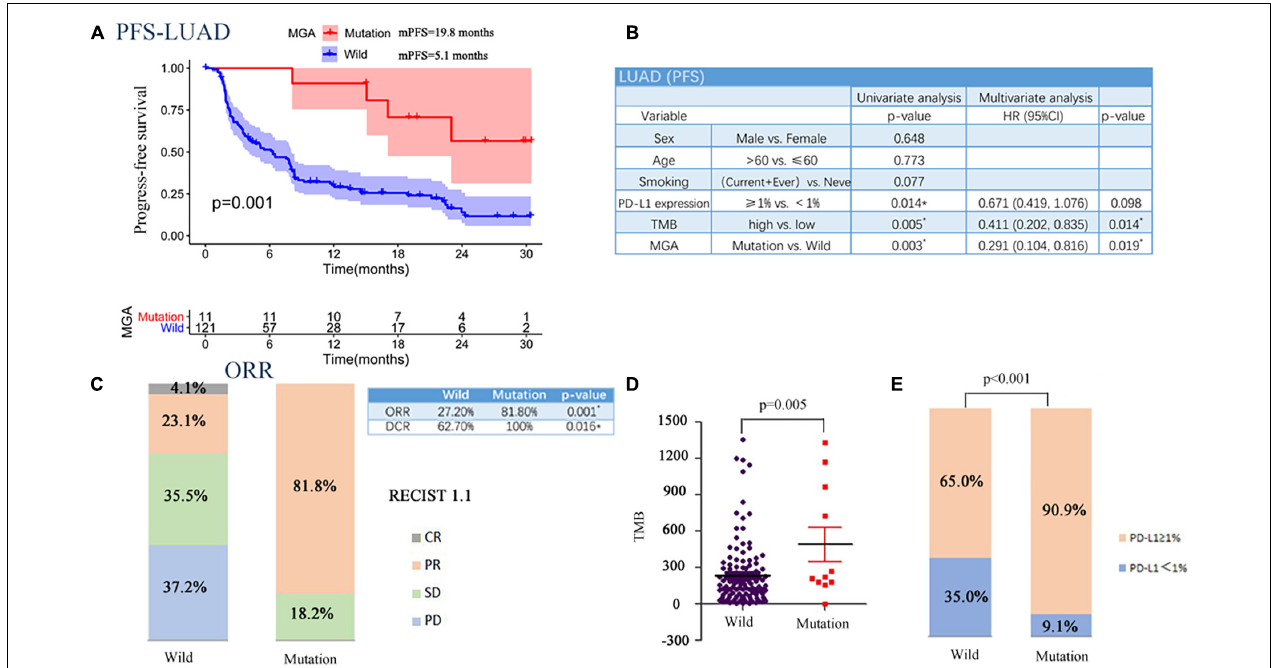
FIGURE 4 | Associations between MGA mutation and PFS in the validation cohort. (A) Kaplan-Meier survival curves comparing PFS between the MGA mutant and wild-type group in the LUAD cohort. (B) The univariable and multivariable Cox regression in PFS of LUAD patients. (C) The ratio of patients with CR, PR, SD, and PD in MGA mutant and wide-type group. (D) The correlation of MGA mutation and TMB. (E) The correlation of MGA mutation and PD-L1 expression. * P < 0.05 was considered to be statistically significant.